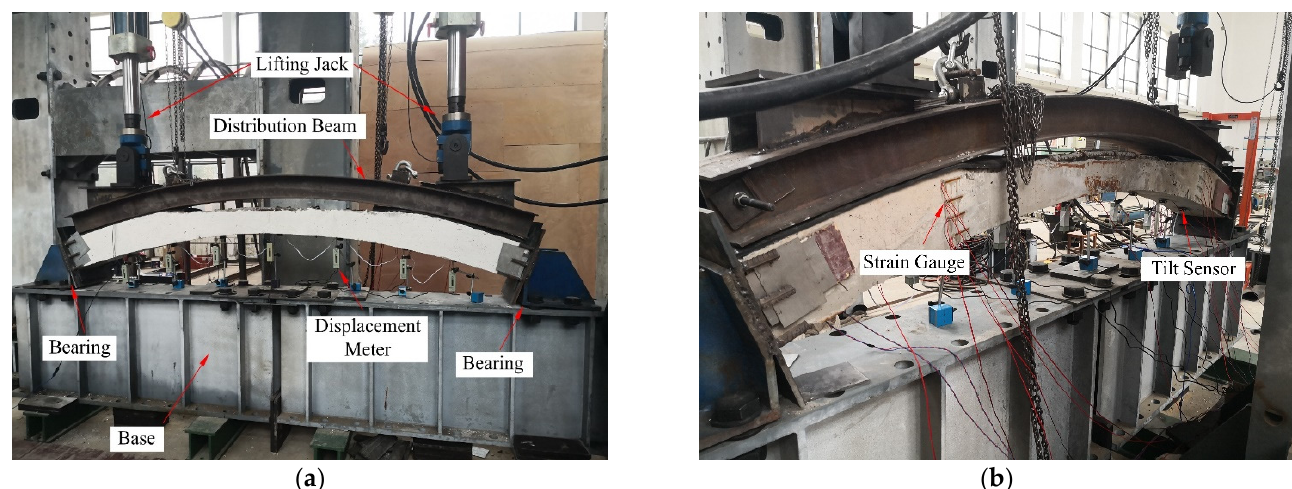
Figure 6. Configuration of the loading system. ( a ) Front of experimental equipment; ( b ) Back of experimental equipment .